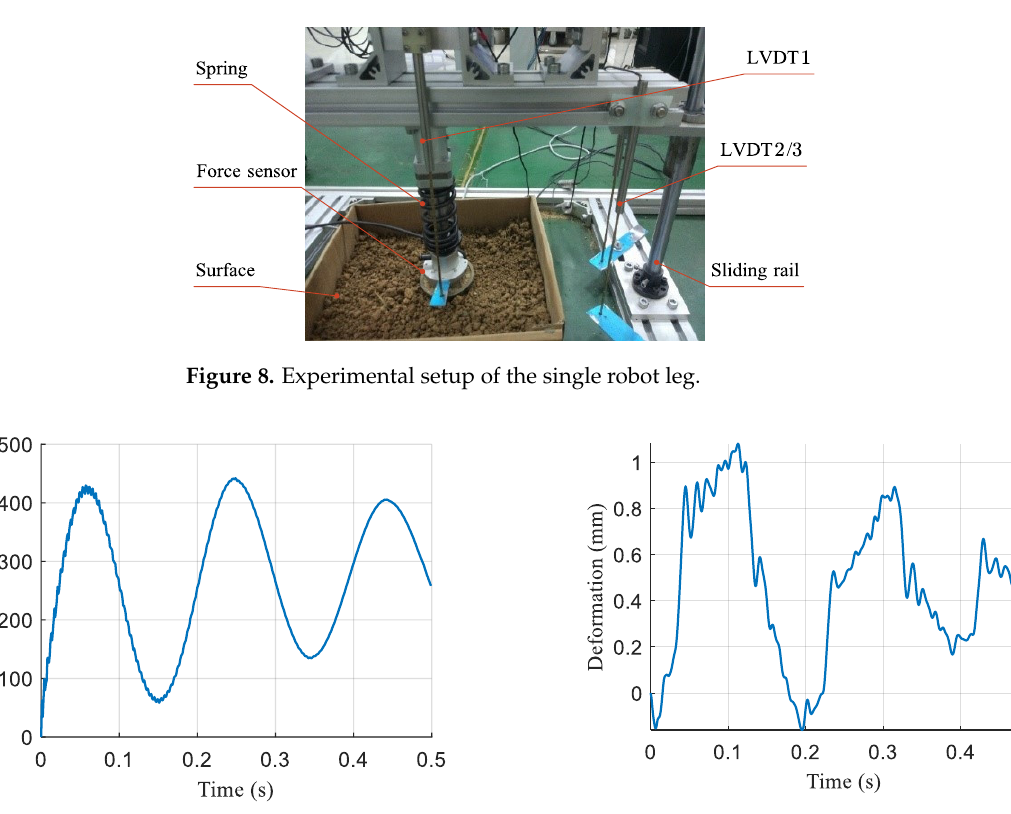
( b ) Figure 7. Comparison of desired/measured position response under impact disturbances. ( a ) PID-based position control- ler; ( b ) proposed controller. 5.3. Experiments on Ground Surface Compliance Estimation The experimental setup of a single robot leg is built for the study of robot–ground contact behaviors. The internal components, including the spring of the robot leg, sub-